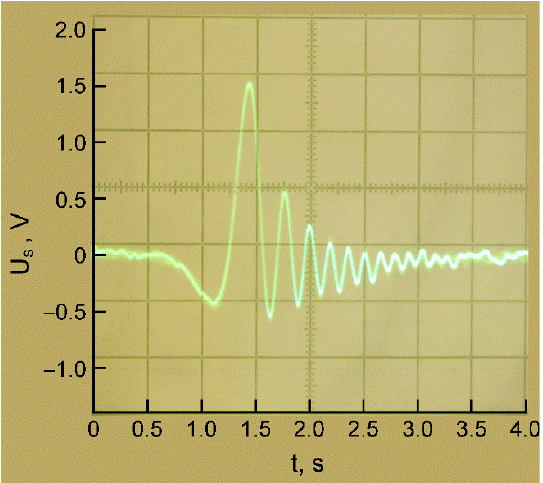
Figure 2. Shape of NMR signal lines at the output of registration circuit 11 from feedwater at H 1 = 0.